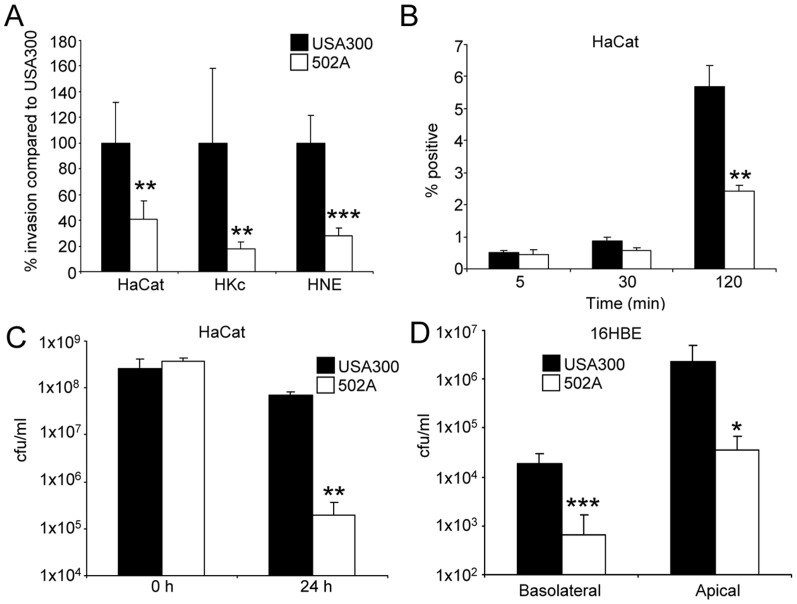

S. aureus 502A is less invasive than USA300.A) Invasiveness of USA300 and 502A was assessed by gentamicin protection assays in HaCat, human keratinocyte (HKc) and human nasal epithelial cells (HNE). Data is presented as a percentage of USA300 bacterial counts (n = 6). B) Uptake of fluorescently labeled S. aureus into HaCat cells. n = 3. C) Transmigration assay of USA300 and 502A. 5×107 cfu of each strain was applied to the apical side of polarized 16HBE airway epithelial cells for 24 h before bacteria were enumerated in the basolateral and apical compartments (n = 16). D) Spent 24 h HaCat culture supernatants were incubated with 2×107 cfu/ml of USA300 or 502A for 24 h before bacteria were enumerated. Data are from at least two independent experiments. ***P<0.001, **P<0.01 and *P<0.05 compared to USA300.